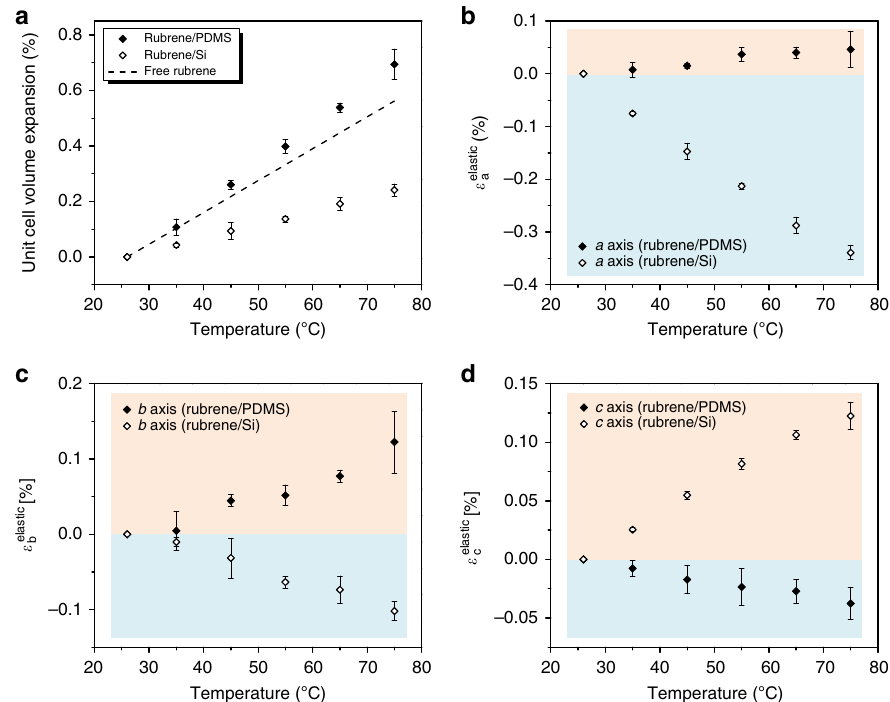
Figure 3 | Unit cell volume expansion and substrate-induced elastic mechanical strain. ( a ) The unit cell volume expansion for rubrene crystals laminated on PDMS and Si as a function of temperature, which are compared with that expected for free crystals. The error bars in unit cell volume expansion were based on the propagation of s.d. errors in e total of the three axes as shown in Fig. 2a,b. ( b ) Average induced mechanical strain ( e elastic ¼ e total (cid:2) e thermal ) along rubrene a axis as a function of temperature for crystals laminated on PDMS and Si, respectively. ( c ) Average e elastic along rubrene b axis as a function of temperature for crystals laminated on PDMS and Si, respectively. ( d ) Average e elastic along rubrene c axis as a function of temperature for crystals laminated on PDMS and Si, respectively. The error bars in e elastic were based on the standard deviation errors in e total as shown in Fig.